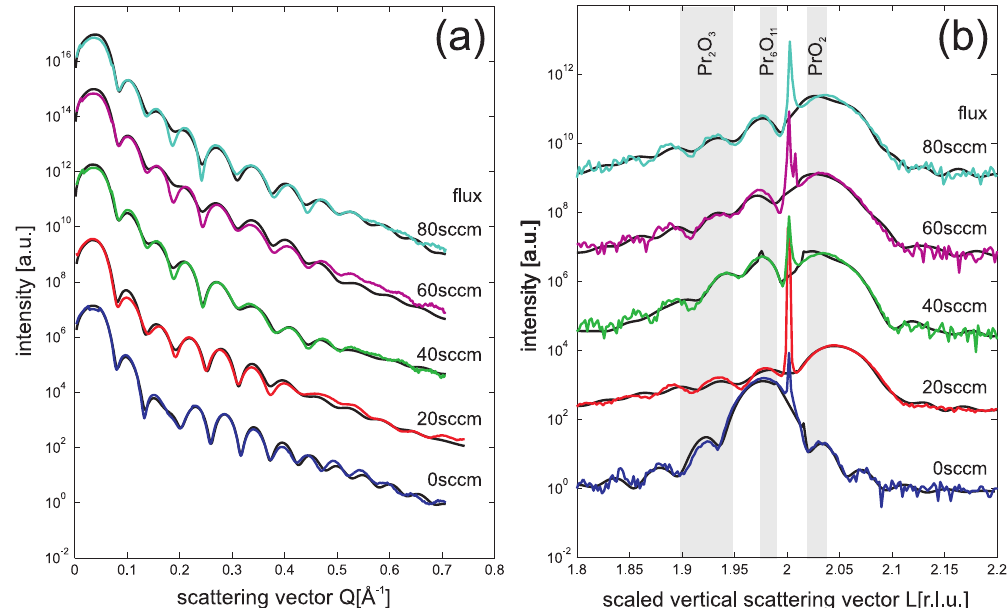
Figure 4. SR-XRR ( a ) and SR-XRD ( b ) data obtained from 9 nm praseodymia films using different O fluxes during plasma treatment (20–80 sccm) keeping other parameters 2 (26 Pa O , 15 min treatment time) constant. The lowest flux of 20 sccm O 2 sufficient to completely oxidize the praseodymia